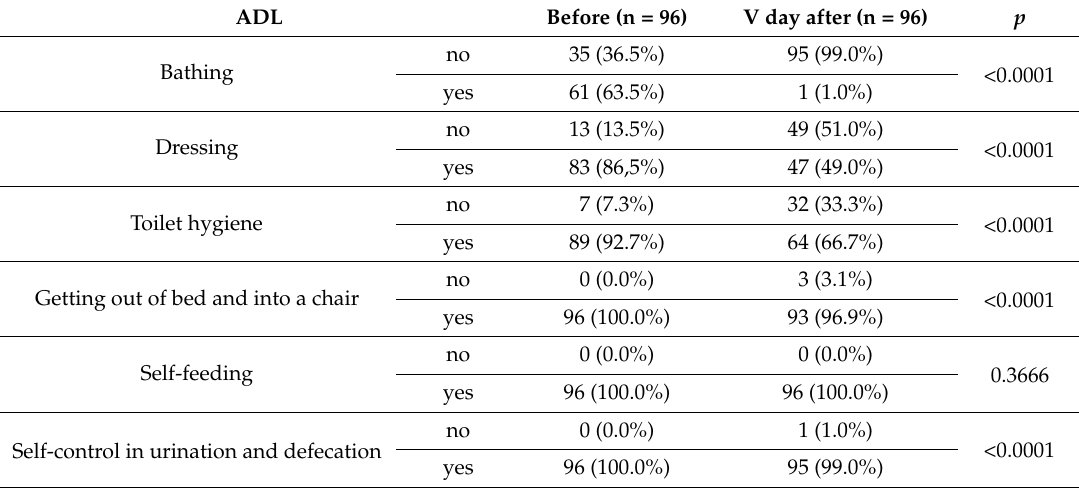
Table 7. Level of functionality of the patients before surgery and on the fifth day after surgery. ADL Before (n = 96) V day after (n = 96)